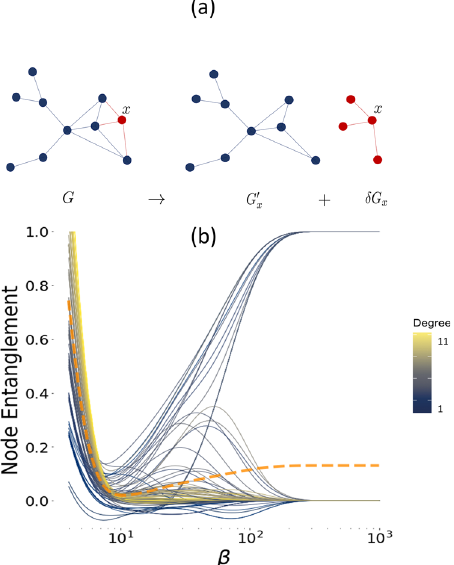
Fig. 1 Detachment process and entanglement centrality. a The process of detaching node x and its incidence edges from the original network G is plotted, forming a perturbed network G 0 , colored in blue, and a star network x δ G x including the detached node x and its neighbors, colored in red for clarity. b The entanglement of each node is shown as a function of the propagation time β , for a random geometric network with the number of nodes N = 100 and radius 0.15, where each trajectory is colored according to the degree of the detached node. In this plot, the vertical axis show the propagation time β and the horizontal encodes the entanglement. The collective entanglement (cid:2) M β , de fi ned as average entanglement of all the nodes, is represented by the orange dashed line that reaches a minimum around the middle